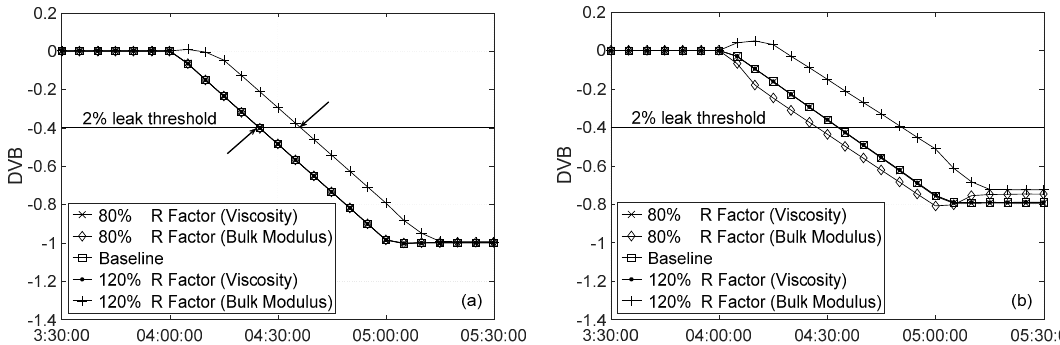
Figure 2. Effect of uncertainty in R factor on leak detectability in a system with R = 2.20 for a flow decrease transient: ( a ) perfect data; and ( b ) noisy data. Arrows in ( a ) indicate the interception between the threshold line and the DVB curve.